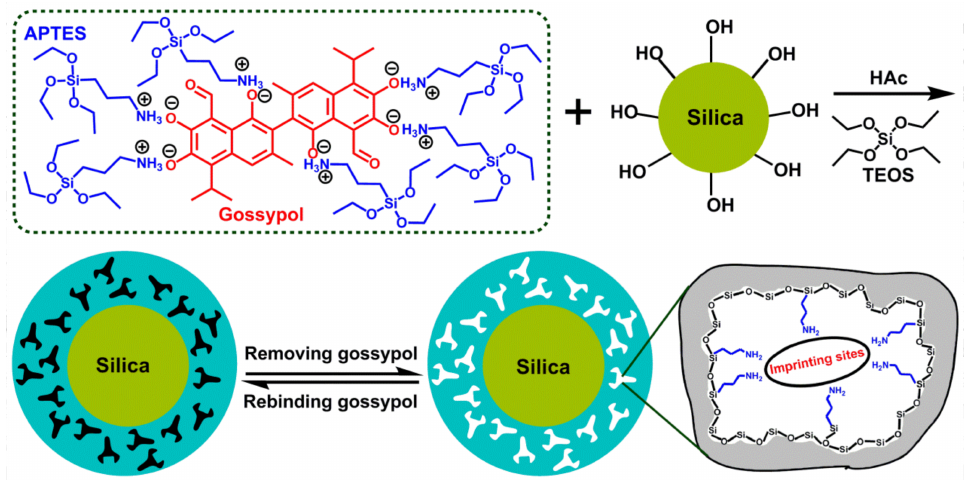
Figure 1. Synthetic route of gossypol-MIPs by combining sol–gel strategy and surface imprinting